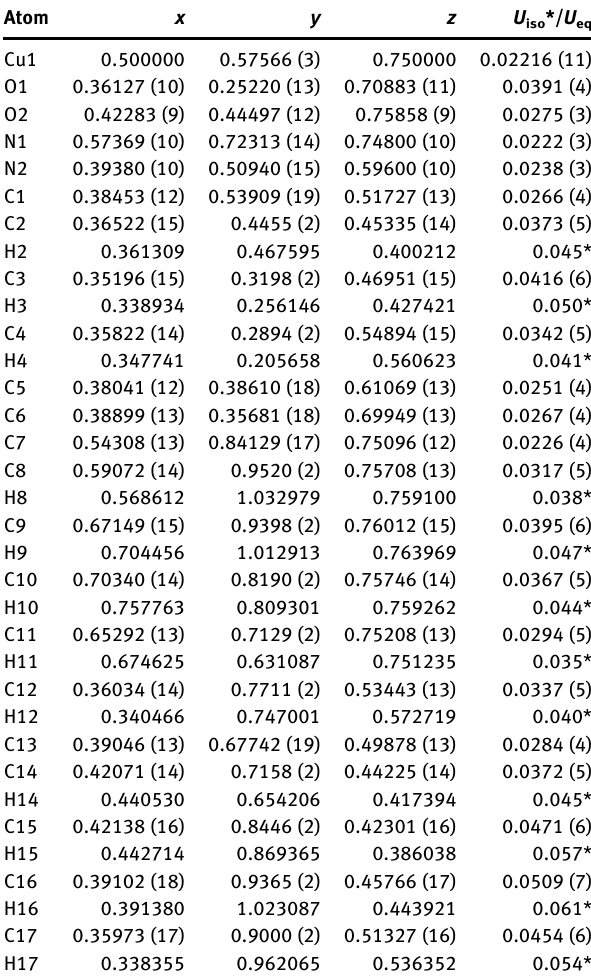
code: ′ 1 − x , + y ,3/2 − z ). The Cu(II) ion locates in a distorted octahedral geometry, de fi ned by one O atom (O2) form one